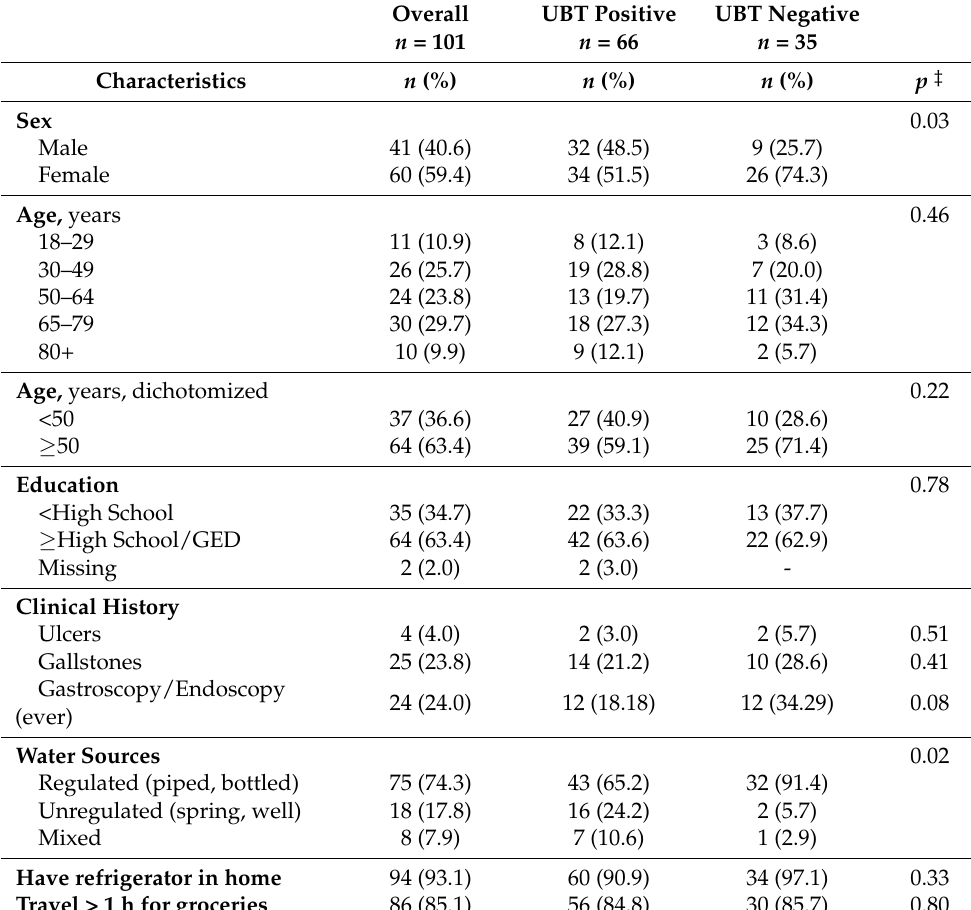
Table 1. Characteristics of participants in the Navajo Healthy Stomach Study by urea breath test (UBT) result.